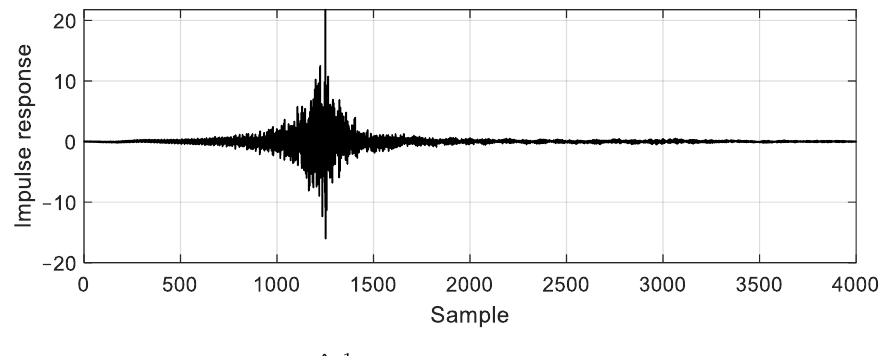
( z ) . ()() S z A z ˆ 0, ∆ 1 (a solid line) is also plotted in Figure ( ) S z − . 0,  ( ) A z ( z ) , which was attained by